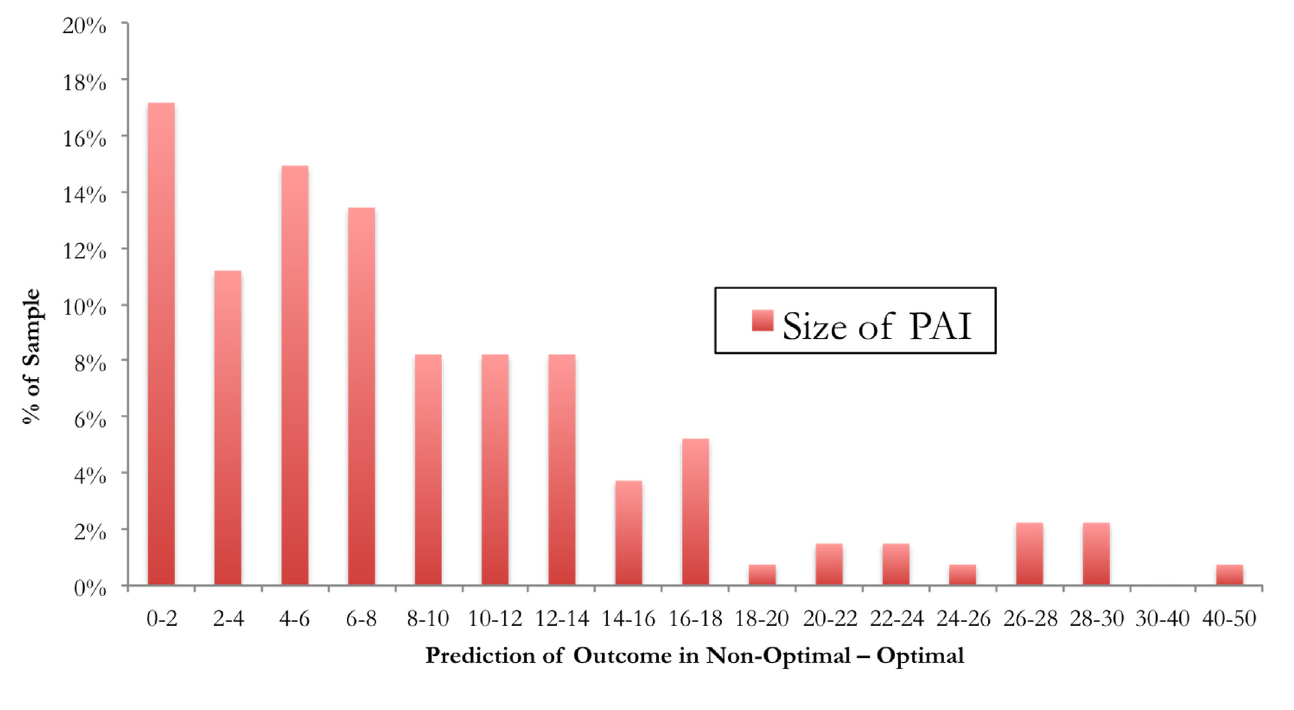
Fig 2. Frequency histogram showing Personalized Advantage Index (PAI) scores for all patients in the sample.